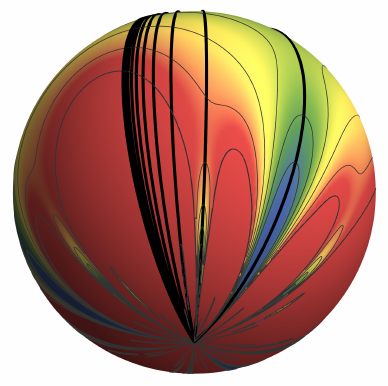
Figure 8. The superposition of the line segments shown in the bottom right panel of Figure 1 onto the sphere shown in Figure 7 under the mapping ˆ S